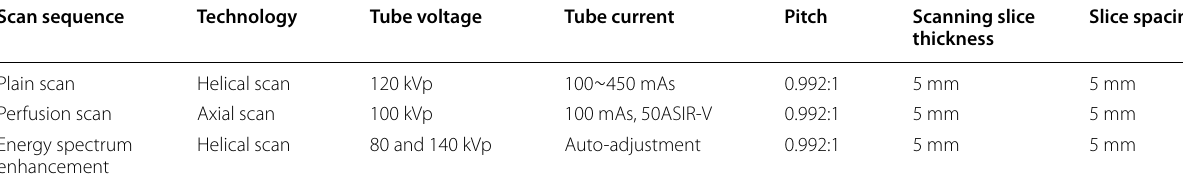
Table 1 Comparison of different CT technical parameters Scan